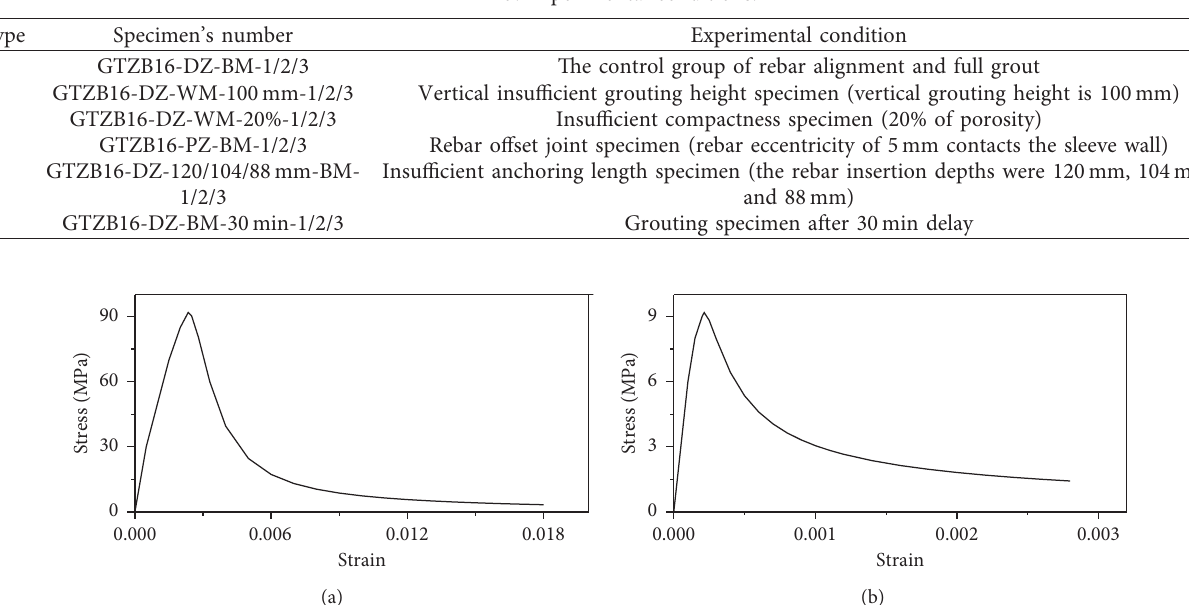
Figure 3: Experimental flowchart. Table 3: Experimental conditions.